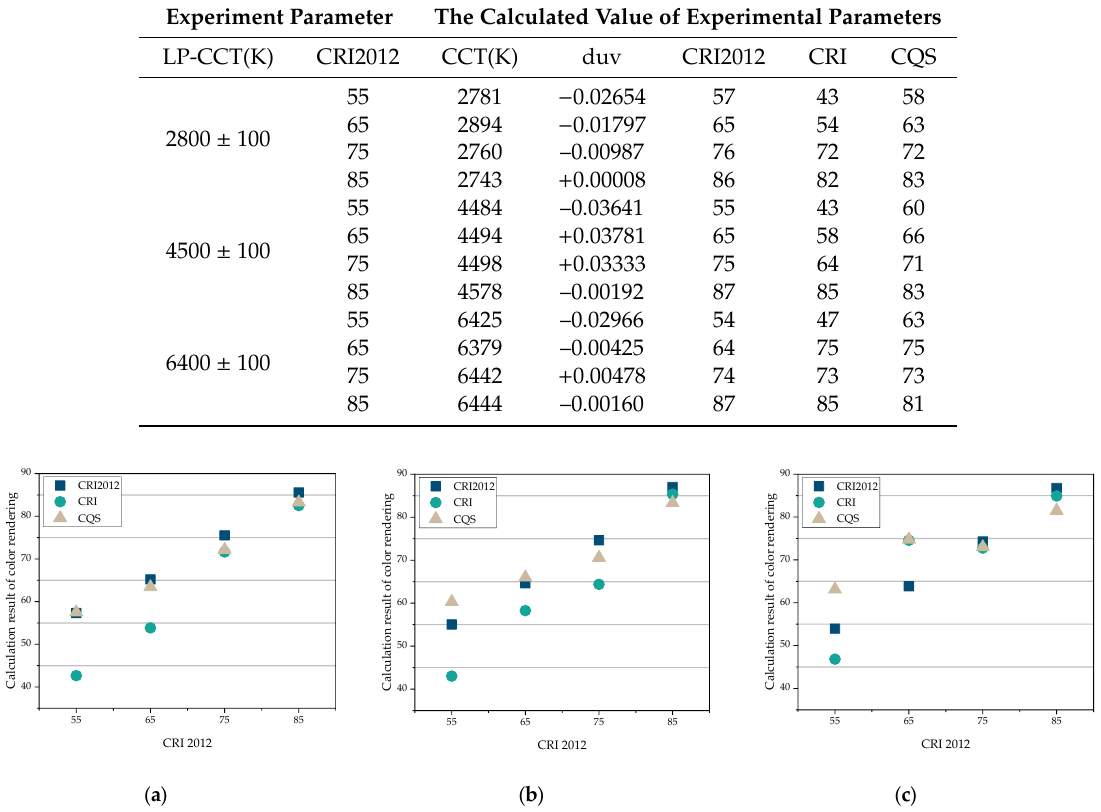
Table 1. The specific values of various parameters of 12 experimental luminaries simulating the tunnel lighting. LP-CCT refers to the CCT simulated by LEDcube. CRI2012 refers to a color di ff erence-based color rendering index; CCT = correlated color temperature; duv refers to the chromaticity di ff erence from the Planckian or daylight locus; CRI = color rendering index; CQS = Color Quality Scale.